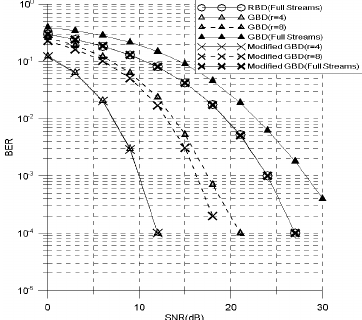
Figure 5. The BER comparison when each of the 4 UEs has 3 receive antennas and the BS has 16 transmit antennas.